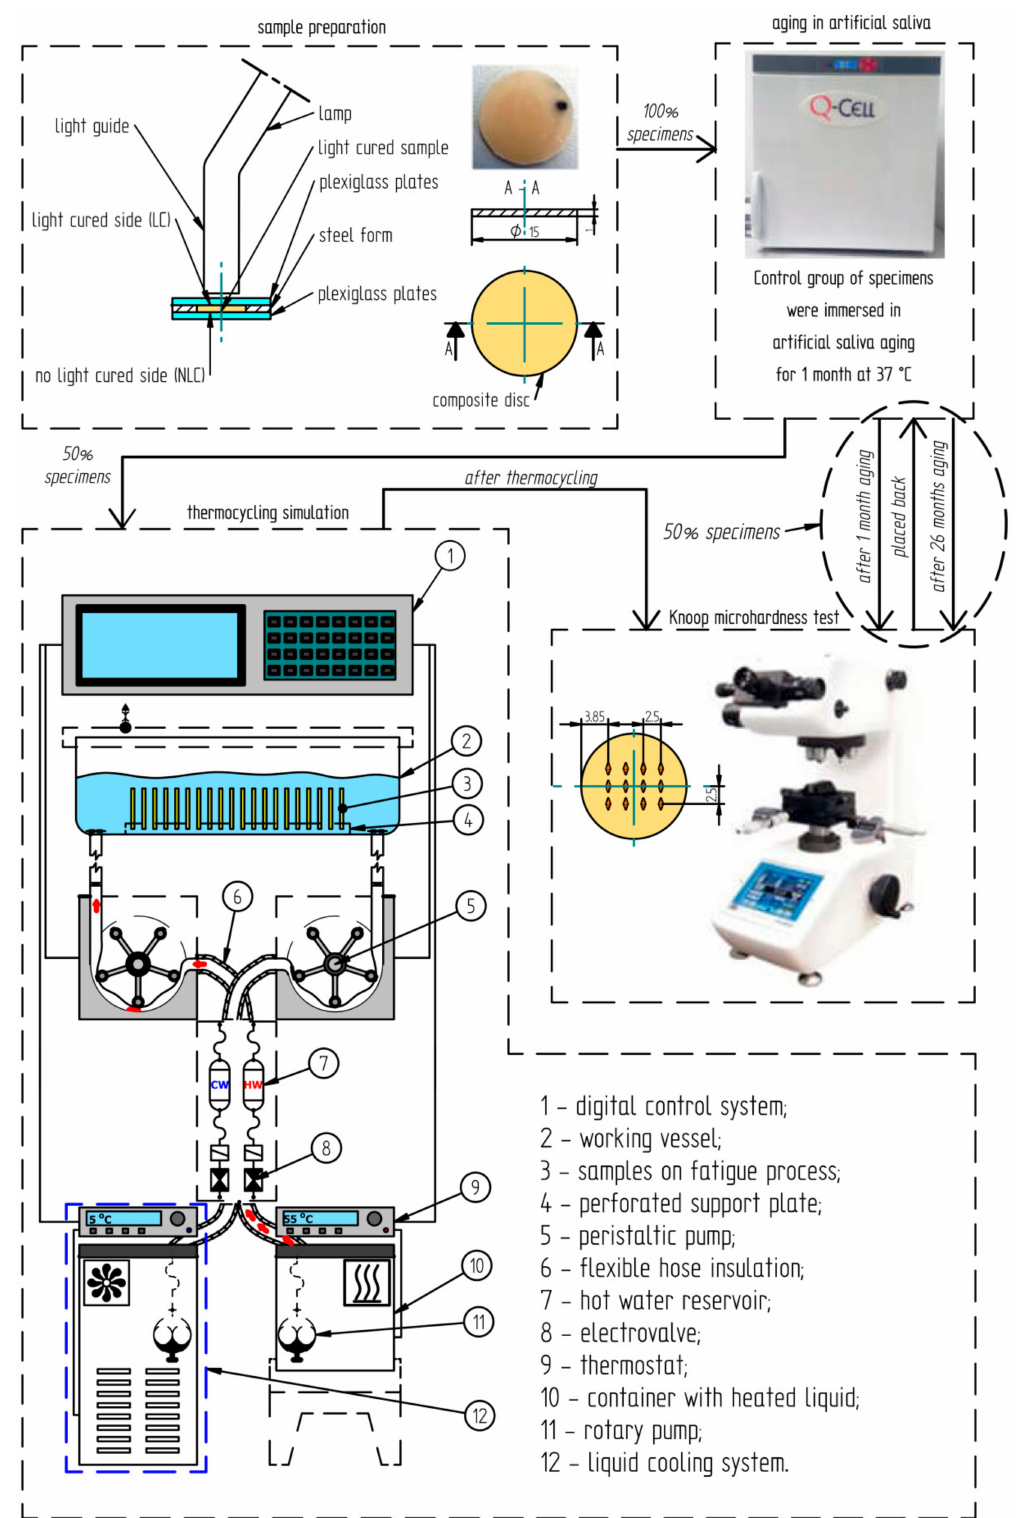
Figure 1. Schematic of the course of testing the dental composite